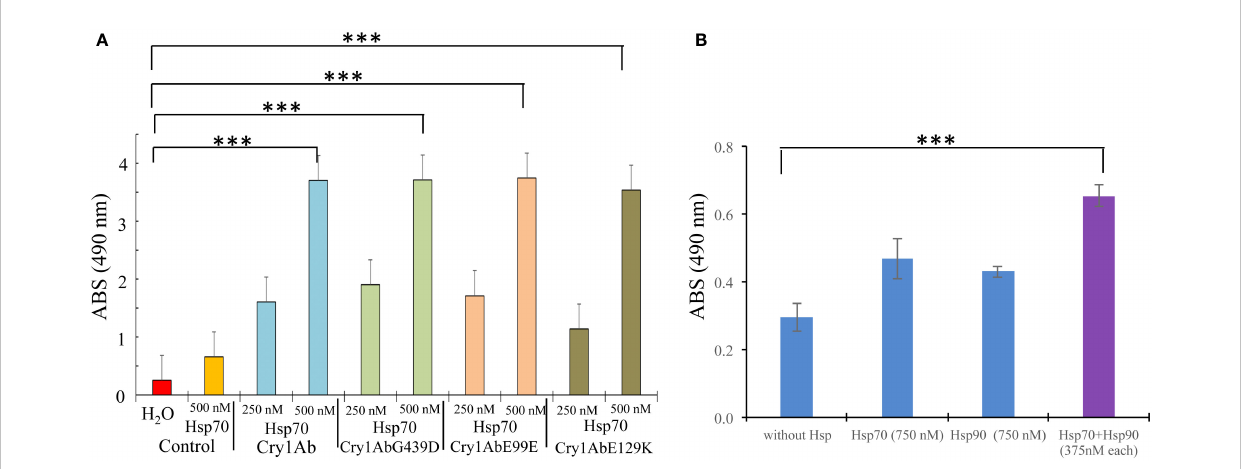
FIGURE 3 PxHsp70 and PxHsp90 assist Cry1Ab protoxin in binding to CAD receptor fragment. (A) ELISA binding assays of Cry1Ab, Cry1AbG439D, Cry1AbR99E or Cry1AbE129K protoxins to PxHsp70. ELISA plates were coated with 0.5 m g of each protoxin and after washing unbound proteins, the plates were incubated with different concentrations of PxHsp70, and revealed with anti-His antibody as described in methods. P values indicated statistically signi fi cant differences: *** p > 0.0001. (B) ELISA binding assays of Cry1AbG439D protoxin (100 nM) and the mixtures of Cry1AbG439D protoxin (100 nM):PxHsp70 (750 nM), Cry1AbG439D protoxin (100 nM):PxHsp90 (750 nM) or Cry1AbG439D protoxin (100nM):PxHsp70/PxHsp90 (375 nM/375 nM)) to CAD CR12. After washing, the toxin bound to the CR12 was revealed with anti-Cry1Ab antibody as described in methods. P values indicated statistically signi fi cant differences: *** p >